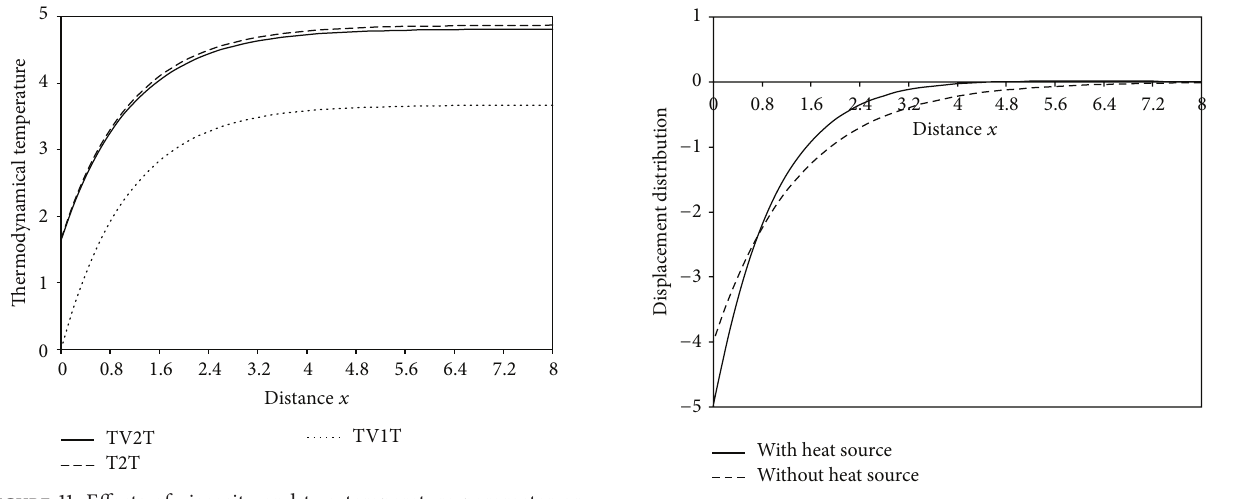
Figure 11: Effects of viscosity and two-temperature parameter on thermodynamical temperature.